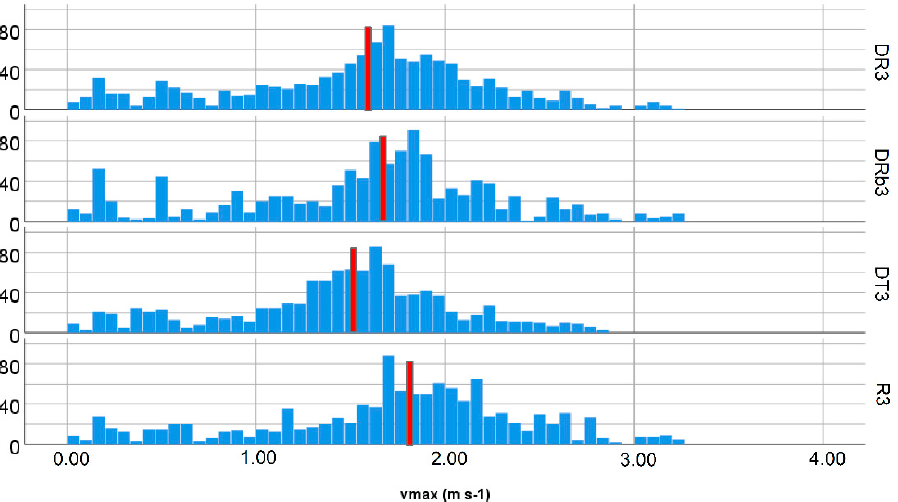
Figure 11. Histogram of maximum velocity by design layout: rectangular boulder (R3), double rectangular boulder (DR3), double rectangular boulder with a small barrier (DRb3) and double trapezoidal boulder (DT3). The red line represents the median values.